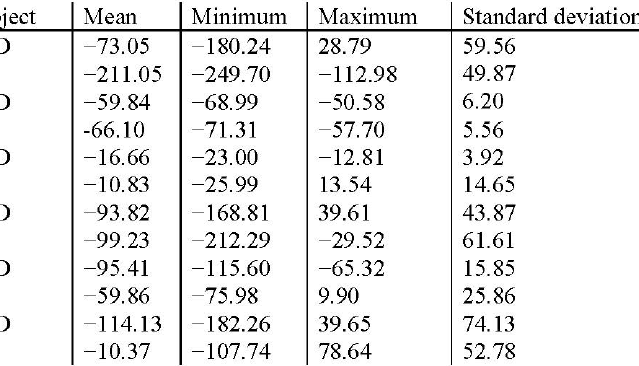
amplitude, minimum, maximum and 1